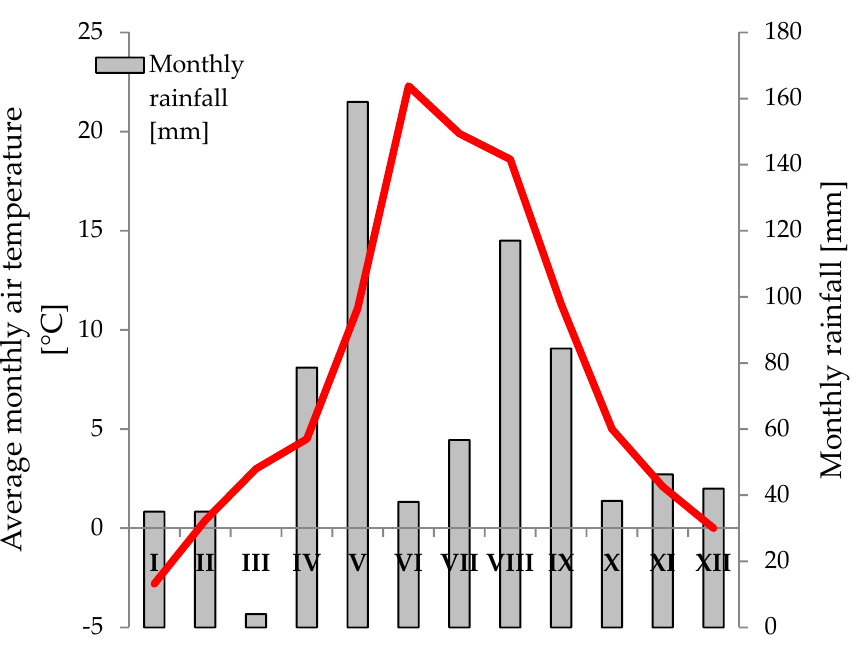
Figure 1. Rainfall and average air temperature at the Plant Breeding Station in Polanowice in 2019.